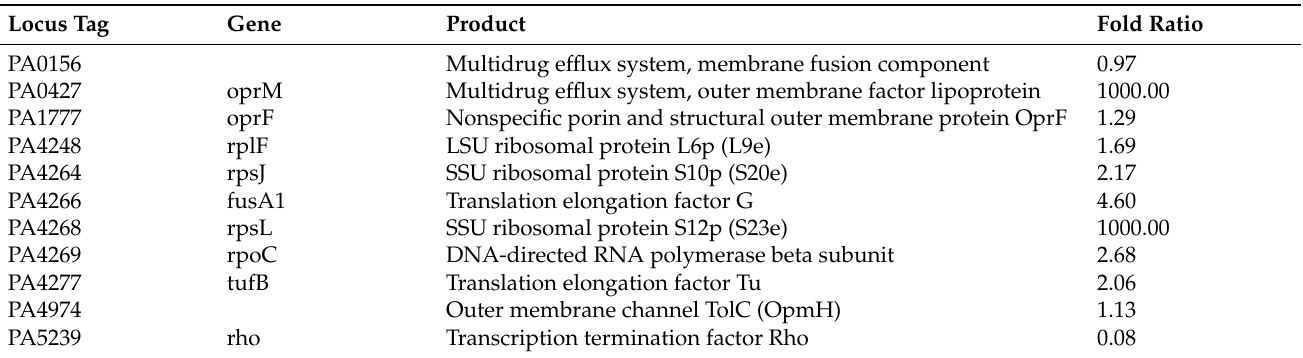
Table 3. Identified proteins associated with antibiotic resistance of biofilm cells grown with control and antibiotic- impregnated